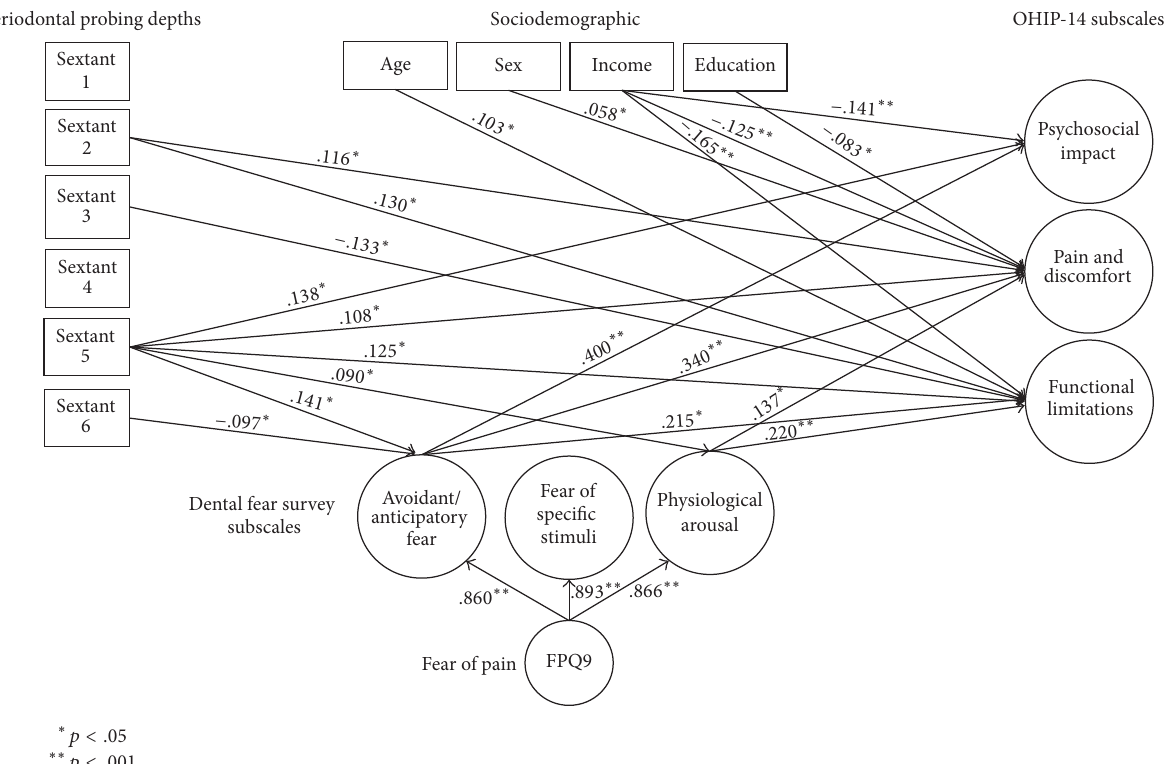
Figure 3: Note. Edentulism assumed to be due to periodontal disease in the model.